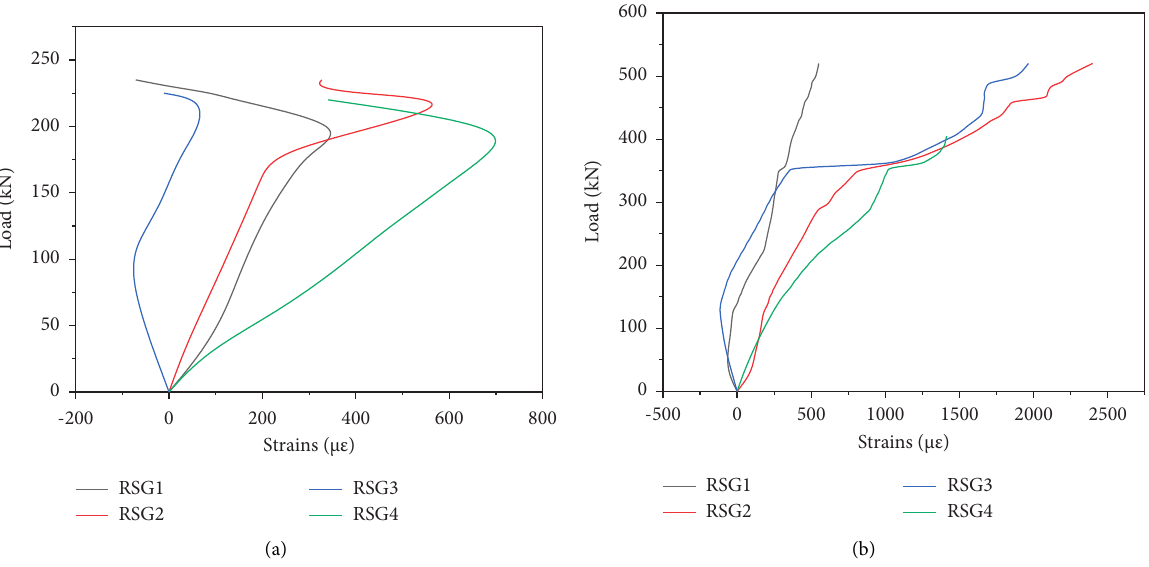
Figure 13: Load-strain curves of reinforcements. (a) Type 2. (b) Type 3.